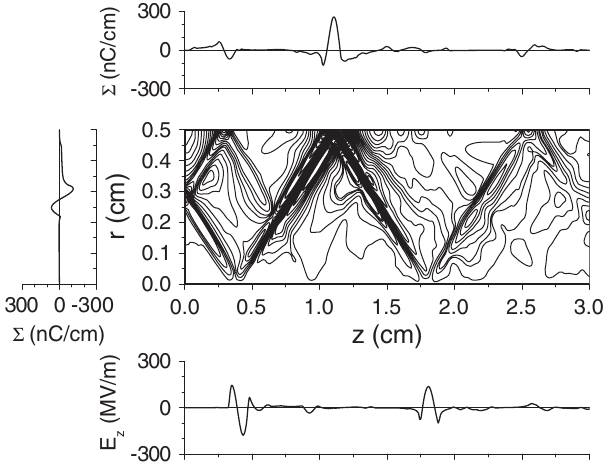
FIG. 11. (Color) Flux lines, axial electric field on the beam axis, and the lineal surface charge density when a beam bunch reaches the middle of the cavity in Fig.